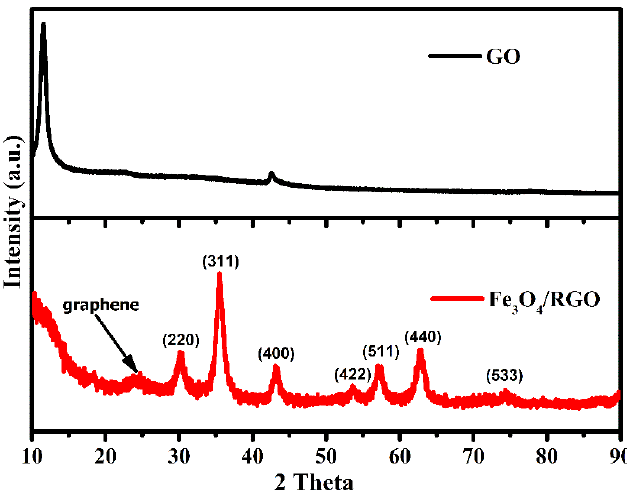
Figure 1. XRD patterns of GO and Fe 3 O 4 /RGO composite material.